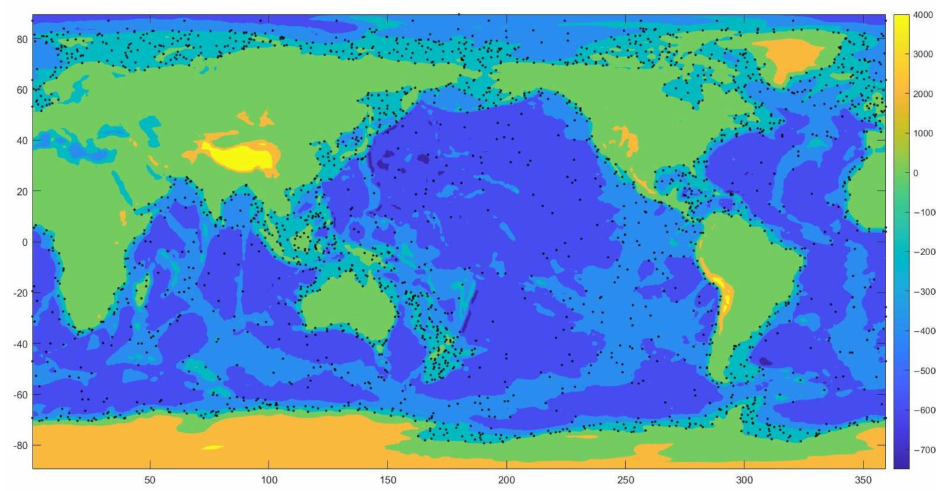
Figure 5. Global ocean node